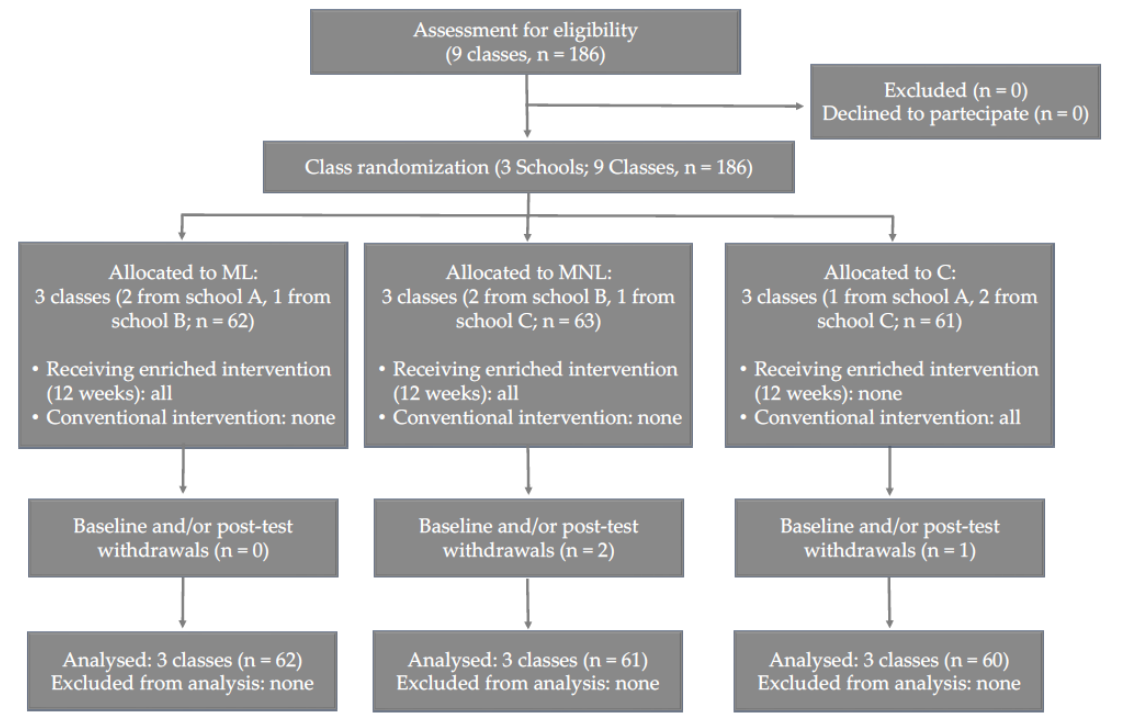
Figure 1. Study flow diagram of the class-randomized